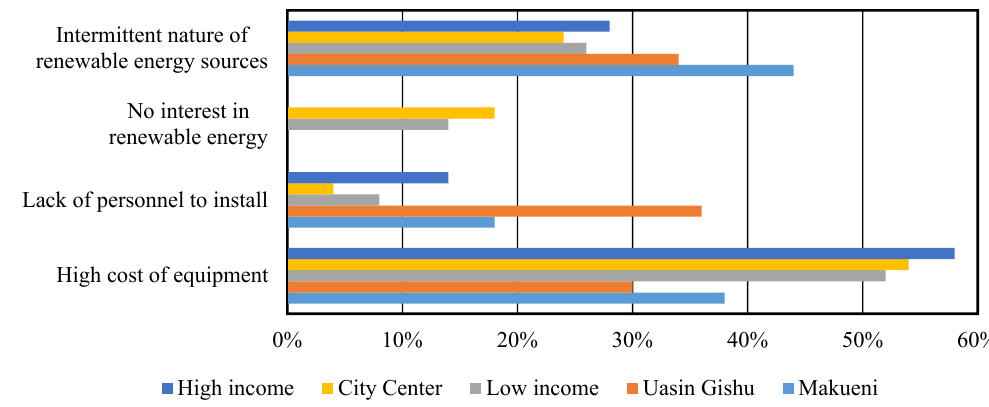
Figure 6. Challenges facing adoption of renewable energy resources.